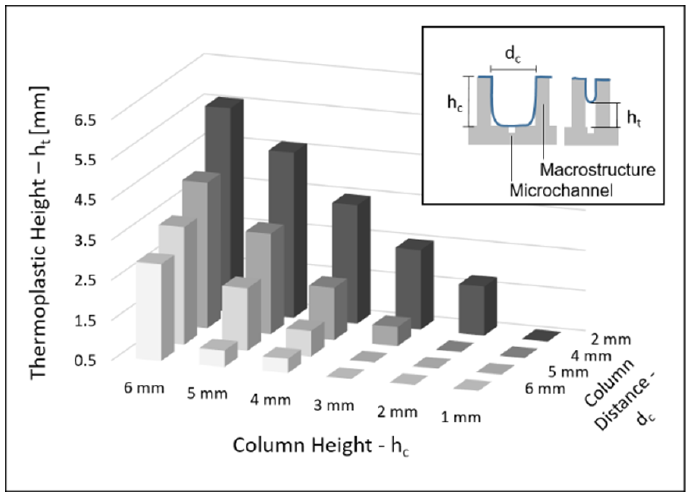
Figure 5. Different structures for the maximum pressure test. Left: Rendering of the structures. Middle: Completed print, sealed with the topographical vacuum forming method. Right: Pressurized channel with water. Top line: Monoplanar structure. Middle line: Prism-shaped structure with 135° and 270° angles. Bottom line: Cube extrusion with 90° angle, 1 mm fillet and 270° angle.